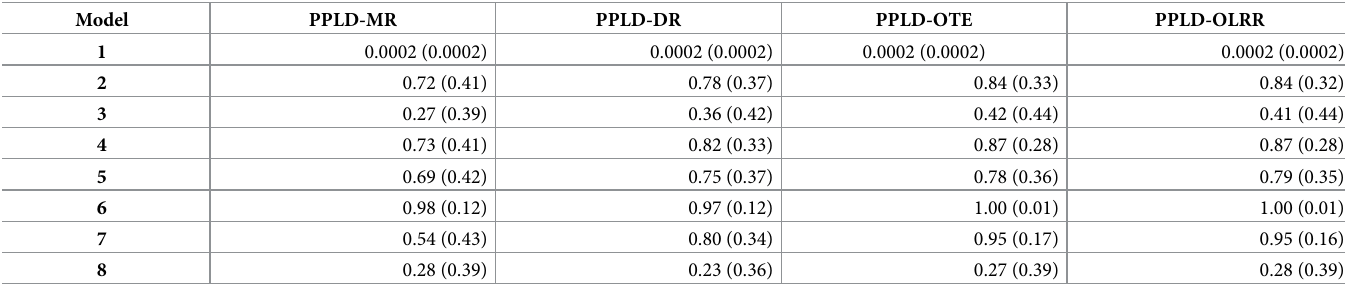
Table 3. Mean (standard deviation) of PPLD distributions for each Model in Table